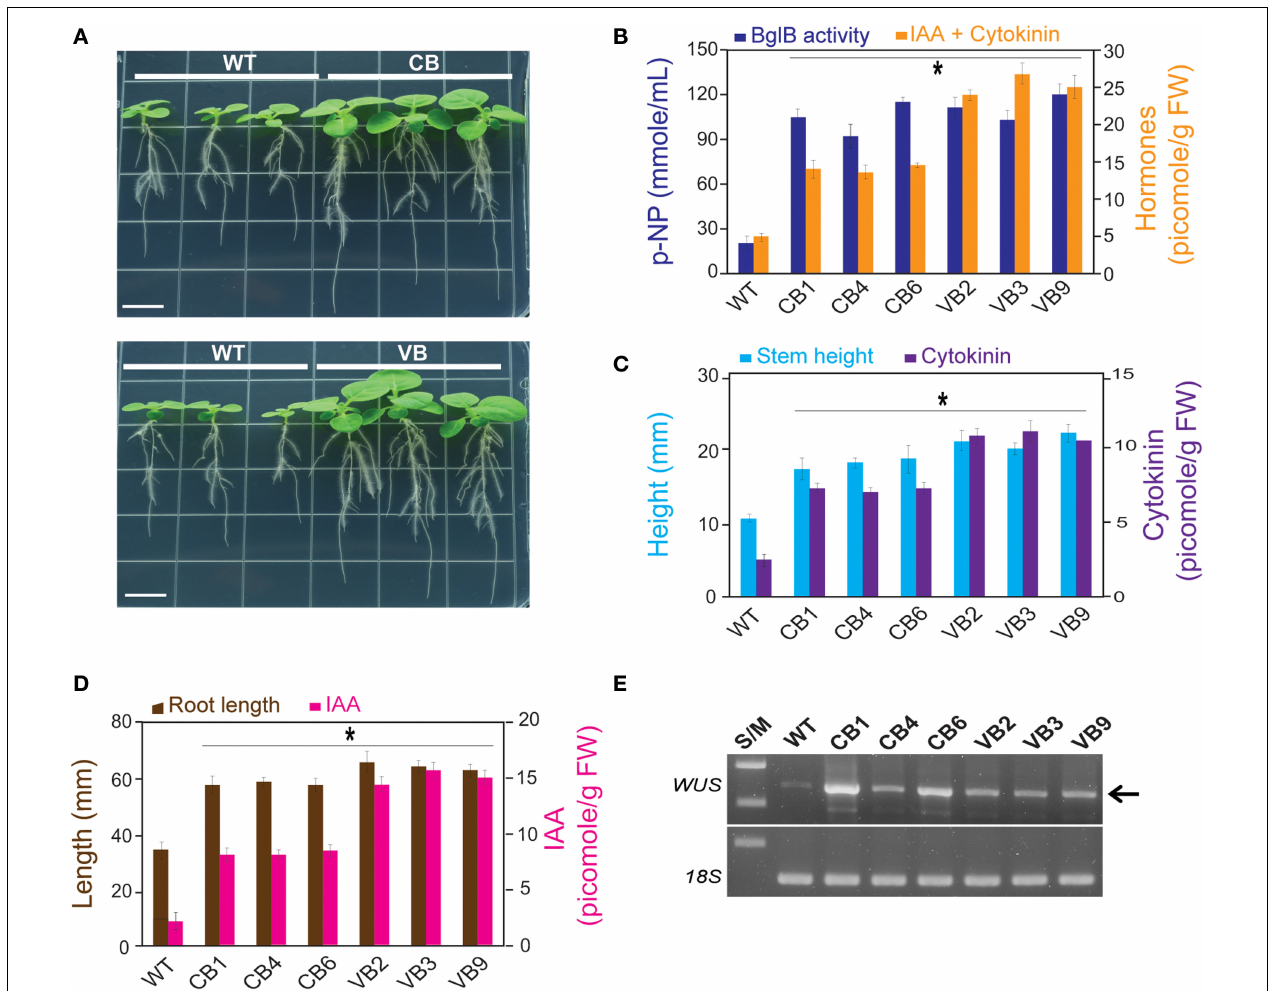
FIGURE 4 | IAA and cytokinin are involved in faster development of the stem and root of the transgenic plants . After 15 DAG: (A) faster development of the stem and roots of young CB and VB transgenic young plants compared to WT plants; (B) Combination of β -glucosidase enzymatic activity and total levels of IAA and cytokinin of the CB and VB transgenic and WT plants; (C) Combination of the stem height and cytokinin levels of the transgenic and WT plants; (D) Combination of the root lengths and IAA levels of the transgenic and WT plants; (E) Transcript expression levels of N. tabacum WUS (JQ686923.1) in the transgenic and WT plants. Average values were calculated from triplicate ( n = 3) of each transgenic lines and WT plants for (B) , and twenty individuals ( n = 20) of each transgenic lines and WT plants for (C,D) . *indicates significant differences from the control (WT) ( P < 0.05).